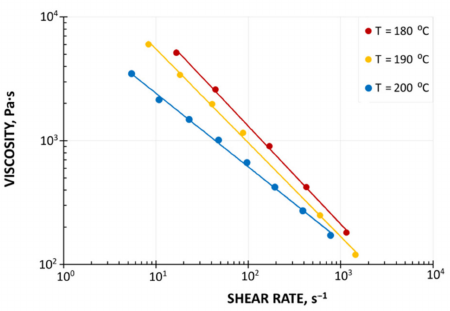
Figure 2. Material characteristics (PP copo inj 4, Beologic): Viscosity curves.